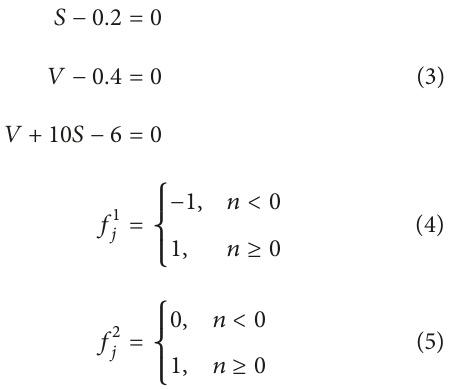
Figure 12: The figure of gait classification.